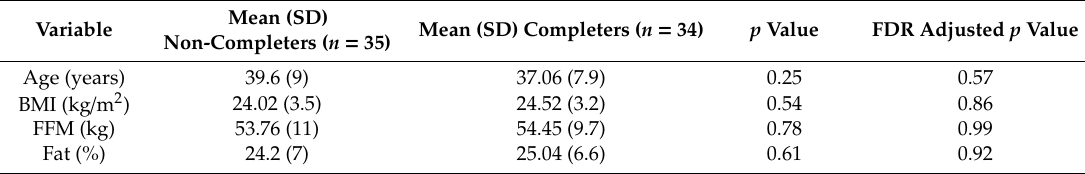
Table 1. Comparison of completers vs. non-completers in body composition before structured exercise programme (SEP).